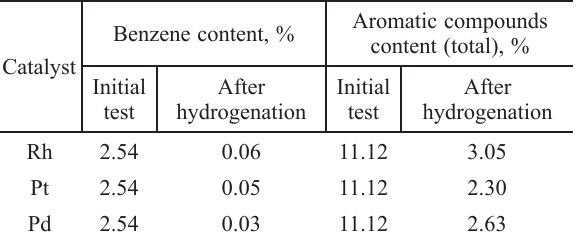
Table 1 – Hydrogenation of “hydrogenate” pos.11-SN-002 KU GBD on 0.5 % monometallic catalysts supported on Al Process conditions: amount of catalyst – 2.0 g; gasoline vol- ume – 30 mL,